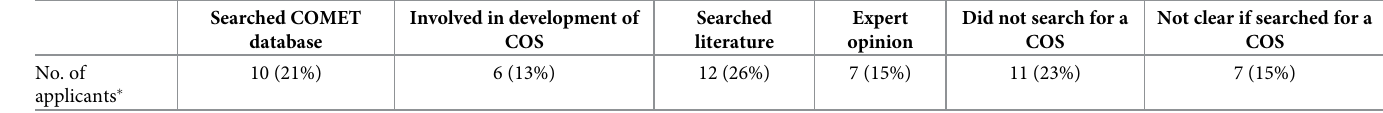
Table 2. Survey responses of 47 applicants about searching for a COS.